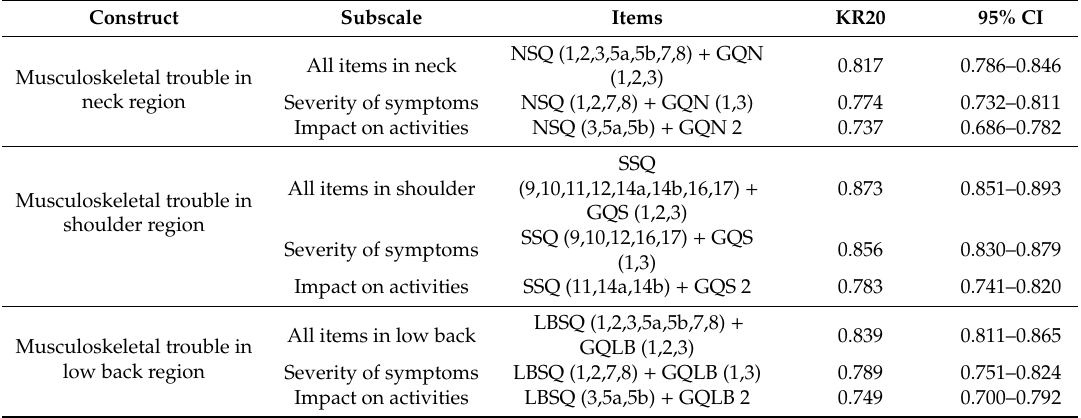
Table 3. Internal consistency verified by the Kuder–Richarson coe ffi cient of reliability ( n = 312).